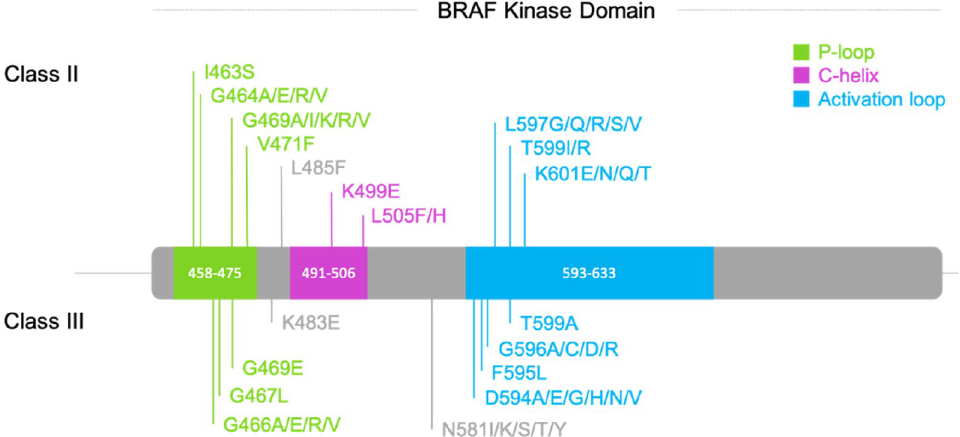
Figure 4. Position of the selected BRAF classes II and III mutations in a schematic representation of the BRAF kinase sequence. Crucial regions P-loop, C-helix and activation loop are colored in green, magenta and blue,